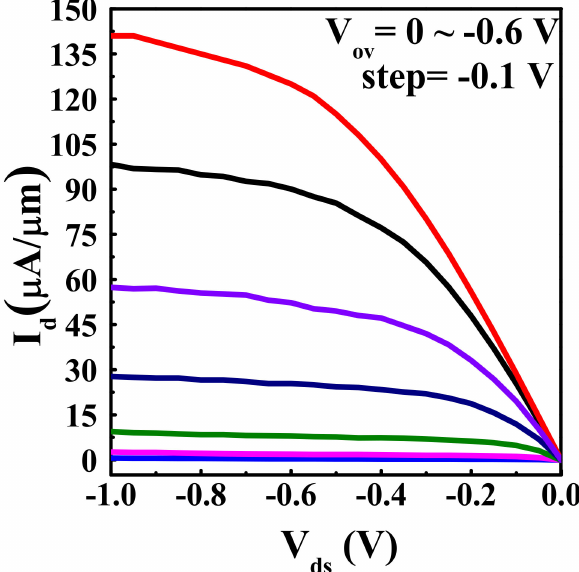
Figure 13. I d –V ds output characteristic curves for Ge pVSAFET with NS thickness of ~27.5 nm, V ov from 0 to − 0.6 V, showing characteristic current saturation behavior. I d normalizes with the perimeter of